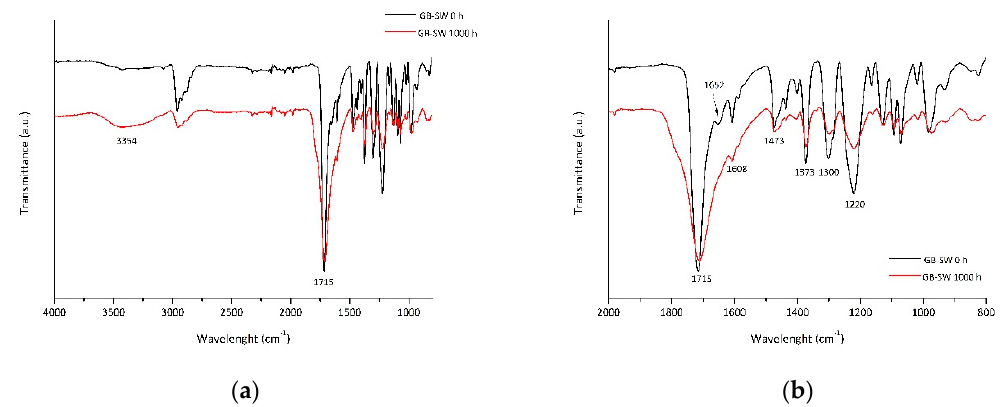
Figure 7. FT-IR spectra of the GB-SW sample before and after 1000 h of UVB exposure: ( a ) reference spectra; ( b ) close-up of the ( a ) image.